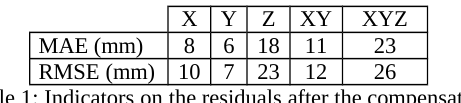
ended in delivering a visually good 3D model. Table 1 details the Mean Absolute Error (MAE) and the Root Mean Square Error (RMSE) of the residuals after the compensation on the 50 GCP.